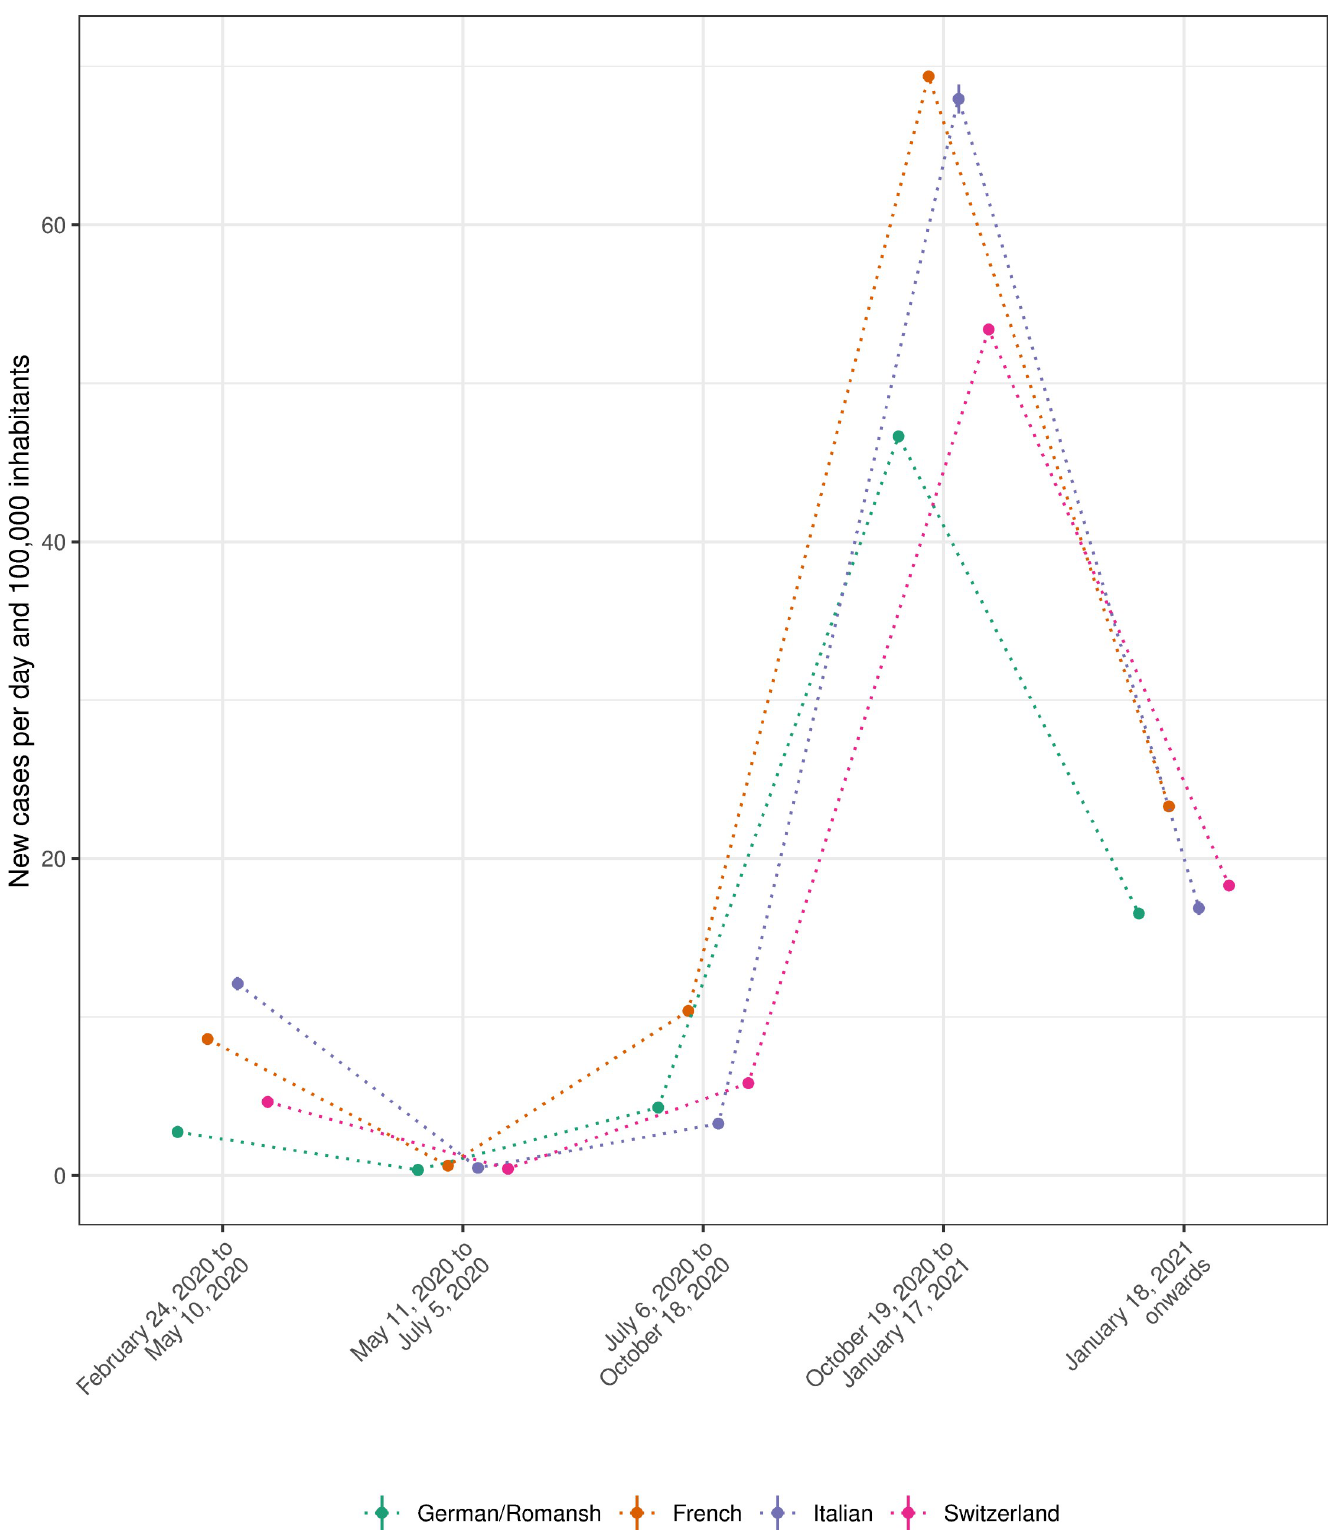
Fig 2. New COVID-19 cases per day and 100,000 inhabitants, by mitigation period and language region.